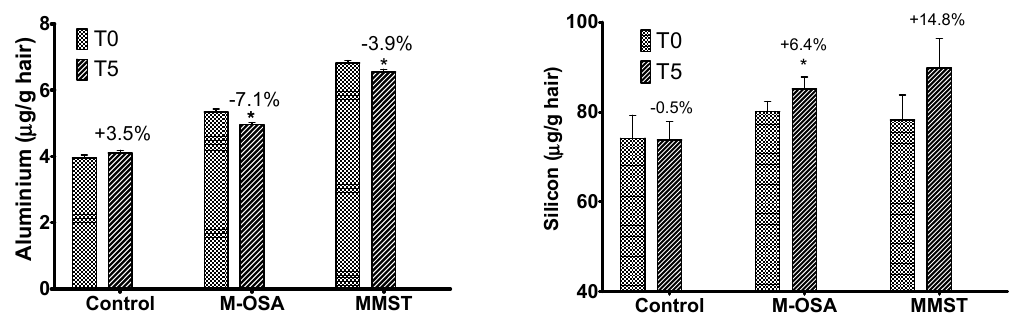
Figure 3. Significative results from hair mineral analysis, as a function of time in the groups. Elements determined as µg per g of hair. * Statistically significant difference from T0. M-OSA = maltodextrin-stabilized ortoshilic acid. MMST = treated with monomethylsilanetriol. T0 = baseline. T5 = 5 months of study.